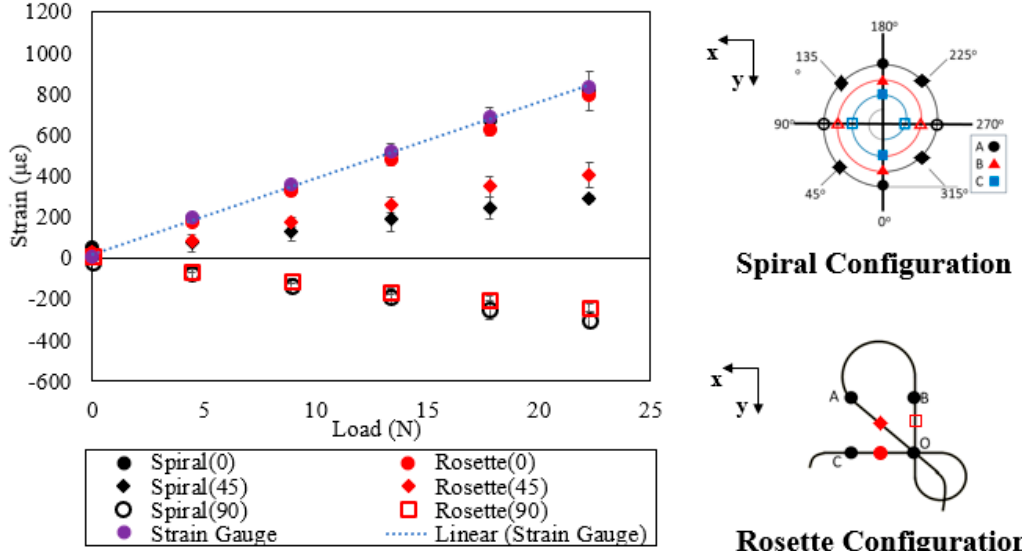
Figure 10. Strains from the 0°, 45°, and 90° directions for the spiral and rosette configurations.